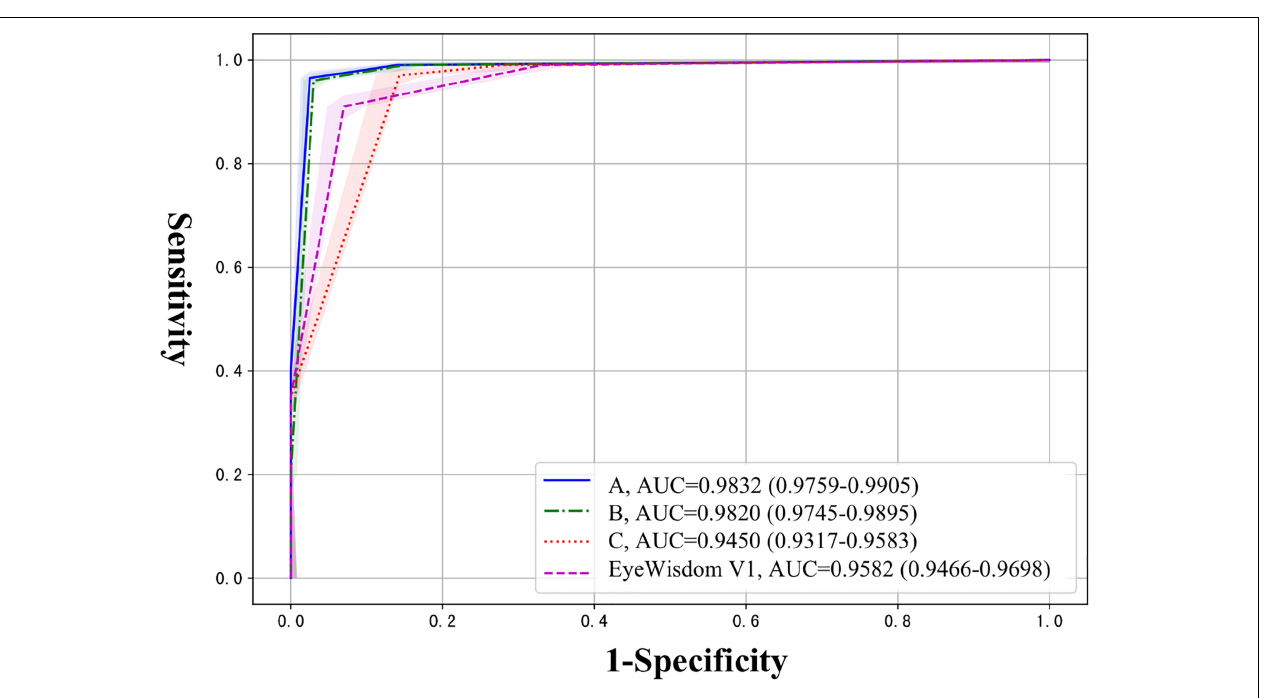
For referral DR, the sensitivity and specificity were